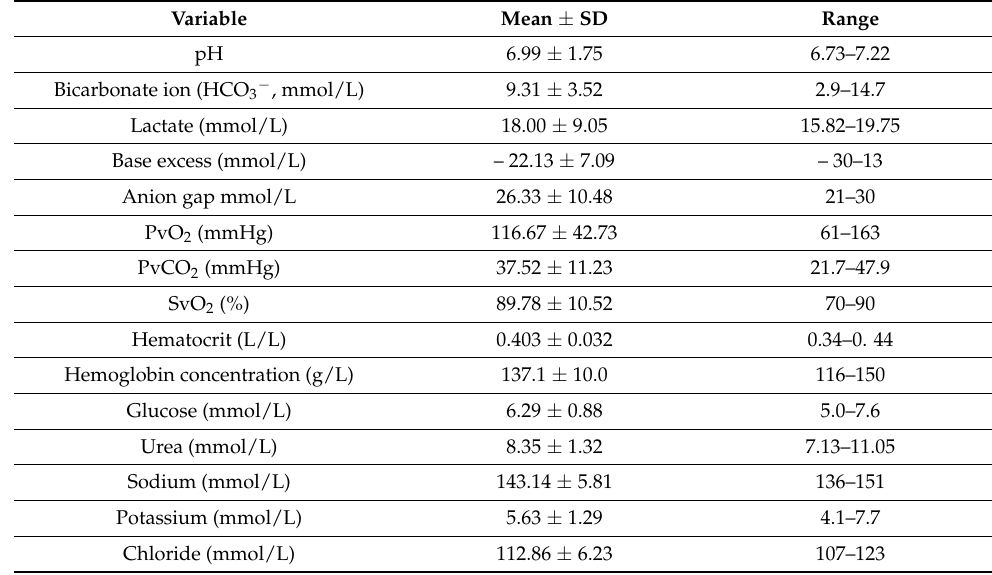
Table 5. Results of venous blood gas analysis of the captured Apennine chamois ( n =